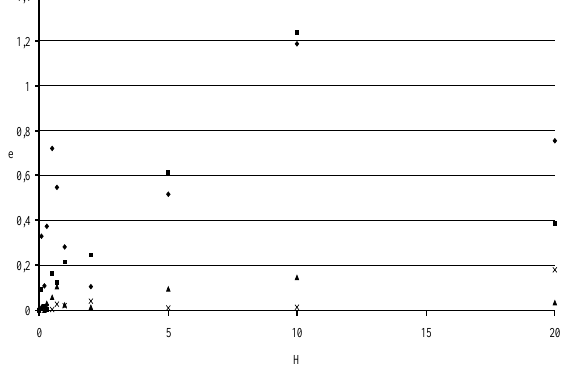
Fig. 3. Distributions of relative errors between theoretical val- ues and computer experiments.